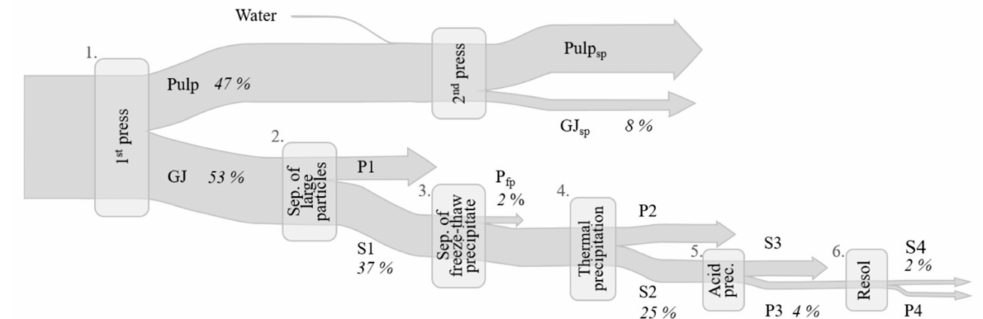
Figure 2. Sankey chart of the full protein extraction process, including all additional steps, with values for mangold as an example. Percentages shown indicate nitrogen flow through the process steps 1–6 (% of initial biomass nitrogen). GJ: green juice, S: supernatant, P: pellet, sp: second press, fp: freeze